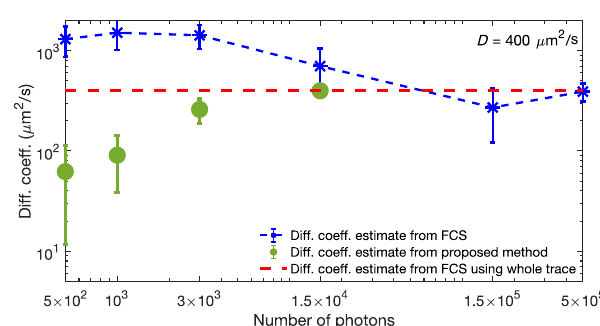
FIG. 12. Diffusion-coefficient estimates of labeled protein. Estimates shown are drawn from experimental traces with fixed concentration 1 nM of Cy3-labeled streptavidin molecules and laser power 100 μ W. Similarly to Fig. 1, we compare our method ’ s diffusion-coefficient estimate (green dots) to FCS (blue asterisk) as a function of the number of photons used in the analysis. Since by 1 . 5 × 10 4 photon arrivals our method has converged, we avoid analyzing larger traces. The red dashed line is the FCS estimate obtained from the entire 5-min trace containing ≈ 3 × 10 6 photon arrivals.